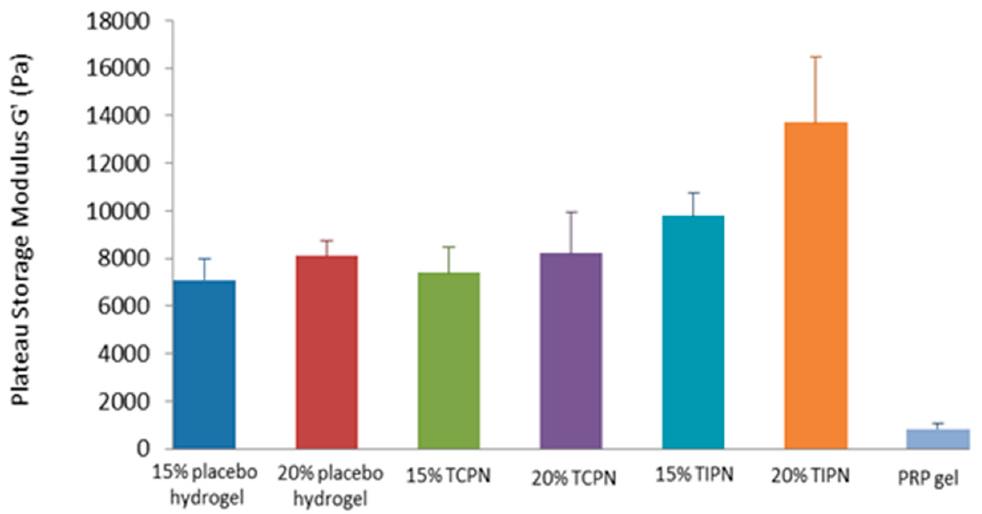
Figure 2. Comparison of storage (G’) moduli as a function of time for different hydrogel formulations.